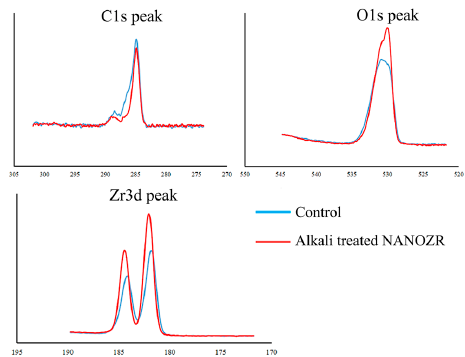
Figure 3. C1s, O1s, Zr3d XPS spectrum of the NANOZR surface (red line: control; blue line: alkali-treated